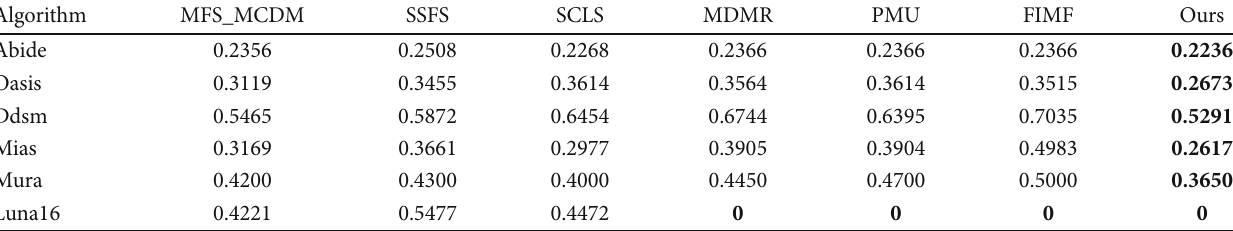
Table 5: Display of optimal experimental results under index one-error.